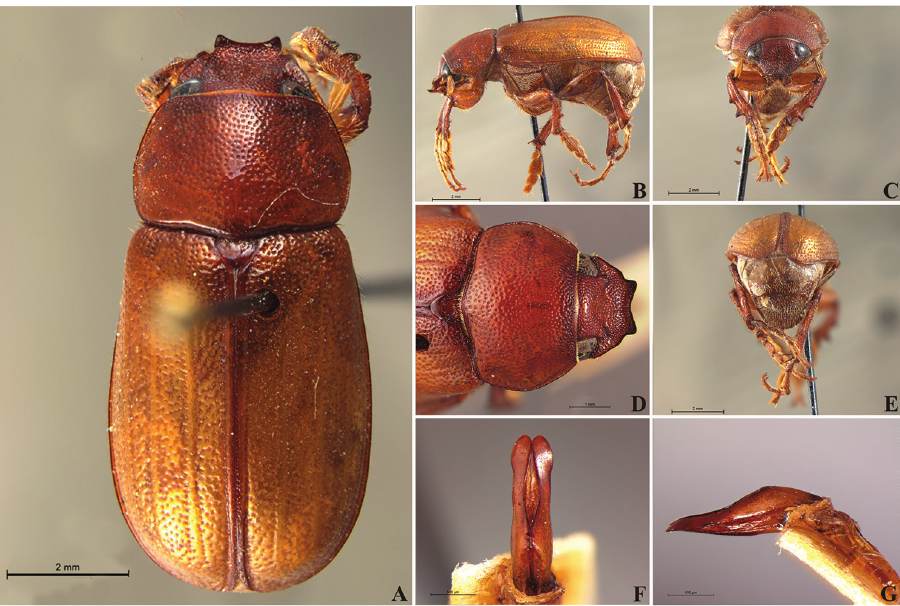
Figure 66. Liogenys moseri Frey. A Dorsal view B Lateral view C Frontal view D Clypeus and pronotum E Pygidium F Parameres, dorsal view G Parameres, lateral